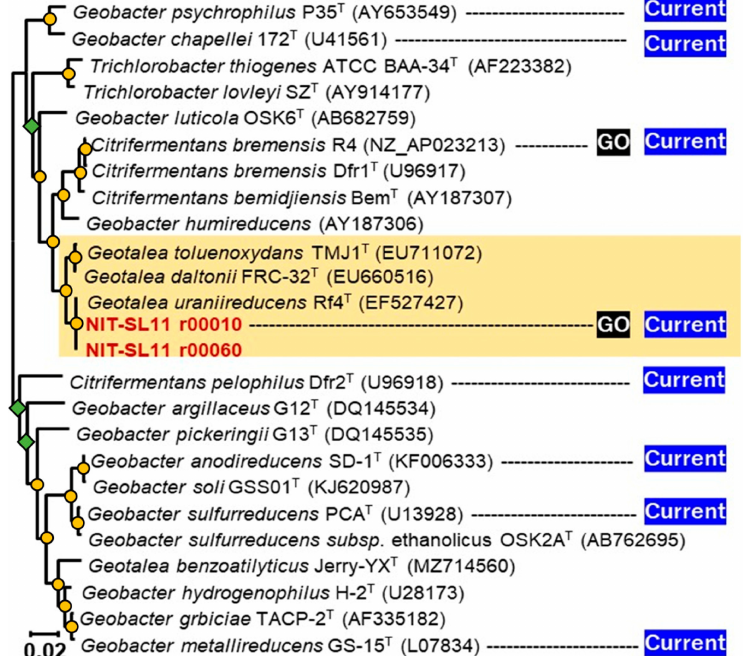
Figure 2. Phylogenetic tree generated using 16S rRNA gene sequences of members of Geobacteraceae family. Yellow circles and green diamonds indicate bootstraps >80% and <60%, respectively. GenBank accession numbers are stated in parentheses; GO: the ability to respire graphene oxide; Current: ability to generate